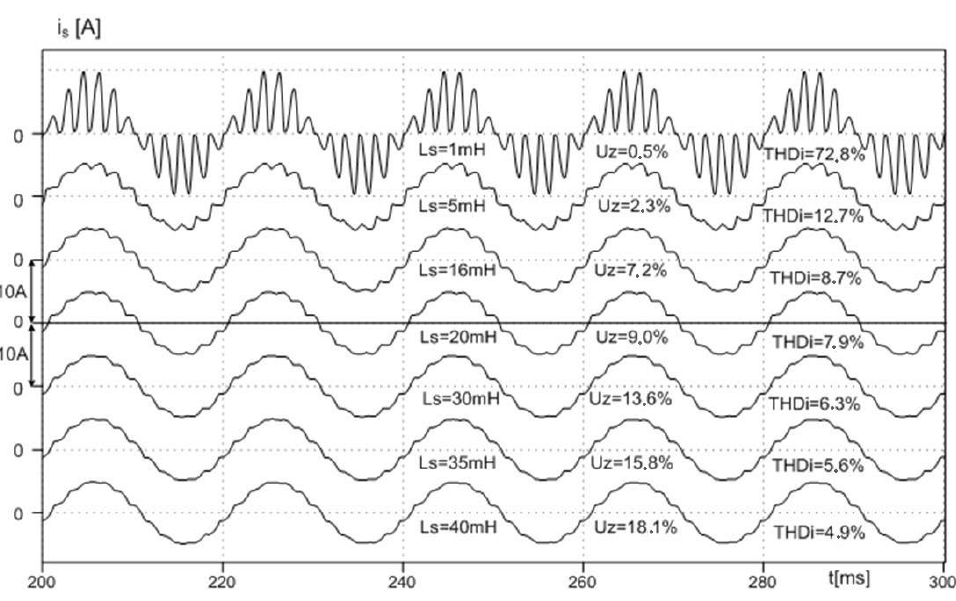
Figure 7. Phase current waveforms determined by L s .